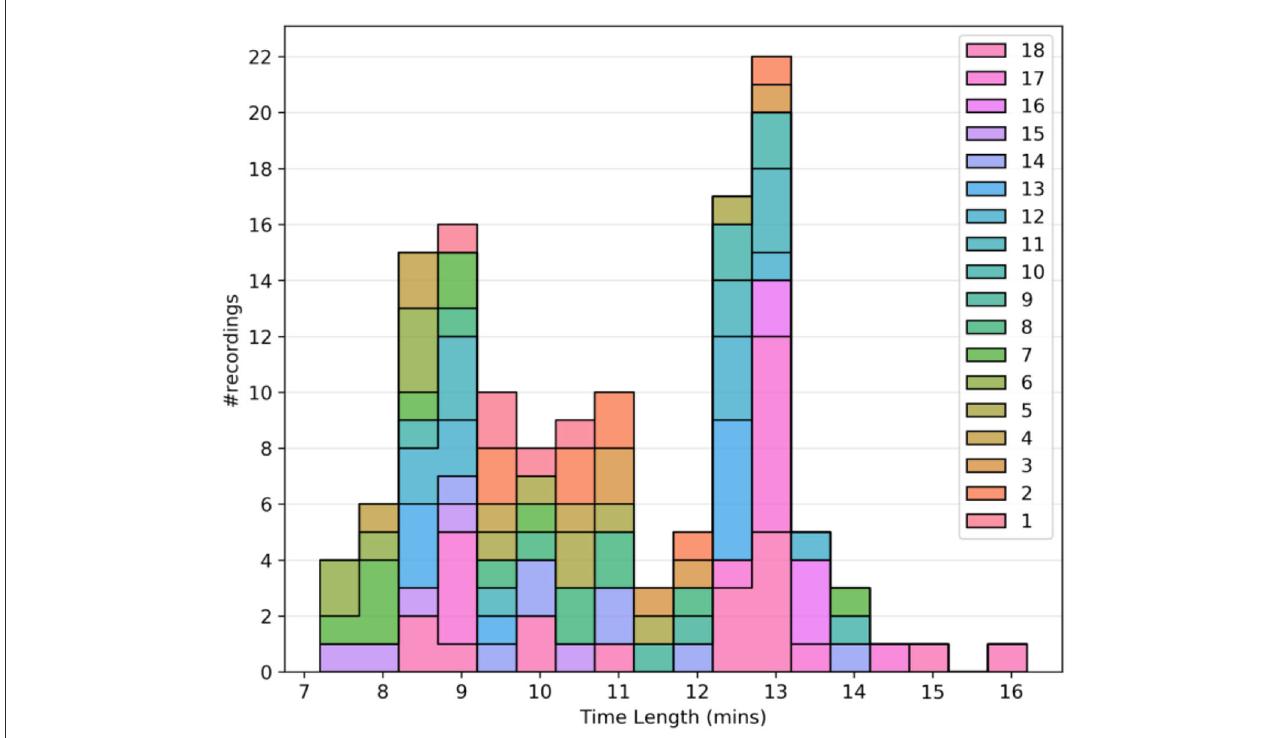
FIGURE1 Quality assurance metrics: Histogram plot of the time length of recordings after time length thresholding. Different colors are used to separate the subjects.